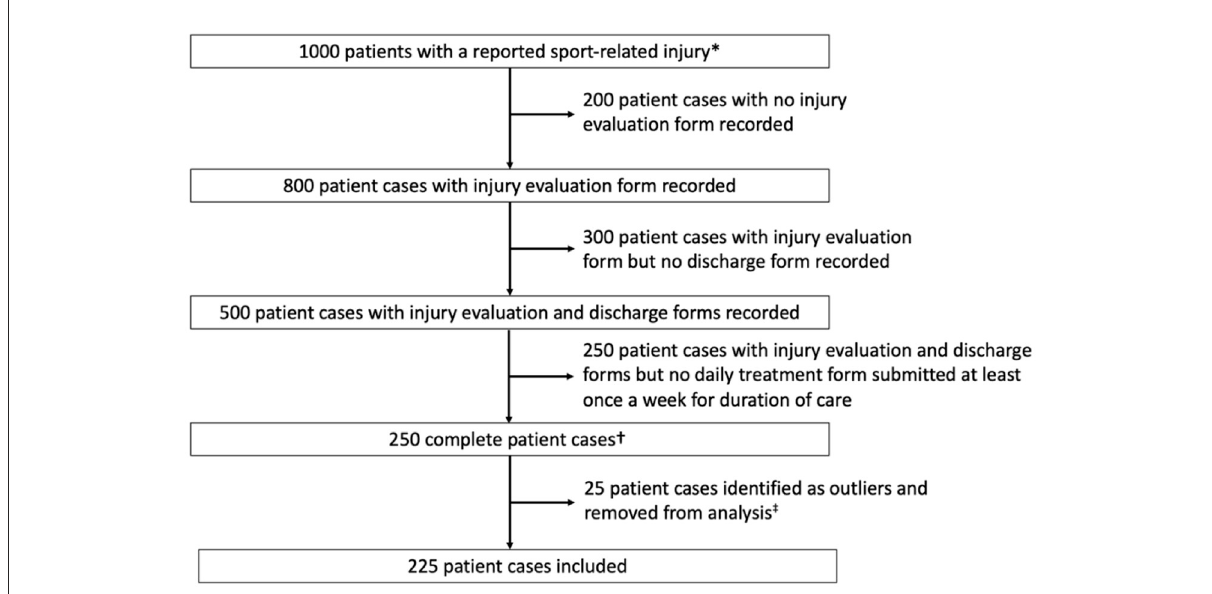
FIGURE2 A flow diagram for selection of study cohort using mock data. *Identified by a submitted injury demographics form to the electronic medical record. † Complete patient cases were operationalized as cases that had (1) an injury demographics form, (2) an injury evaluation, (3) daily treatment forms with at least one encounter per week for the duration of care, and (4) a discharge form. ‡ Outliners were defined as patient cases that exceeded 1.5 times the interquartile